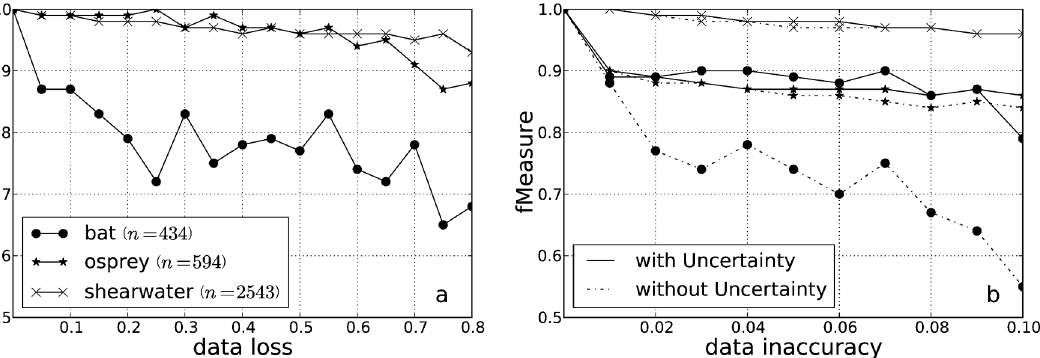
Fig 11. Data loss and data accuracy. EMbC robustness results for a data loss range of 0 (cid:2) k dl (cid:2) 0.8 and for a jittering range of 0 (cid:2) k di (cid:2) 0.1, see Eq (9). For each trajectory the values shown correspond to the average F-measure after 10 different runs.